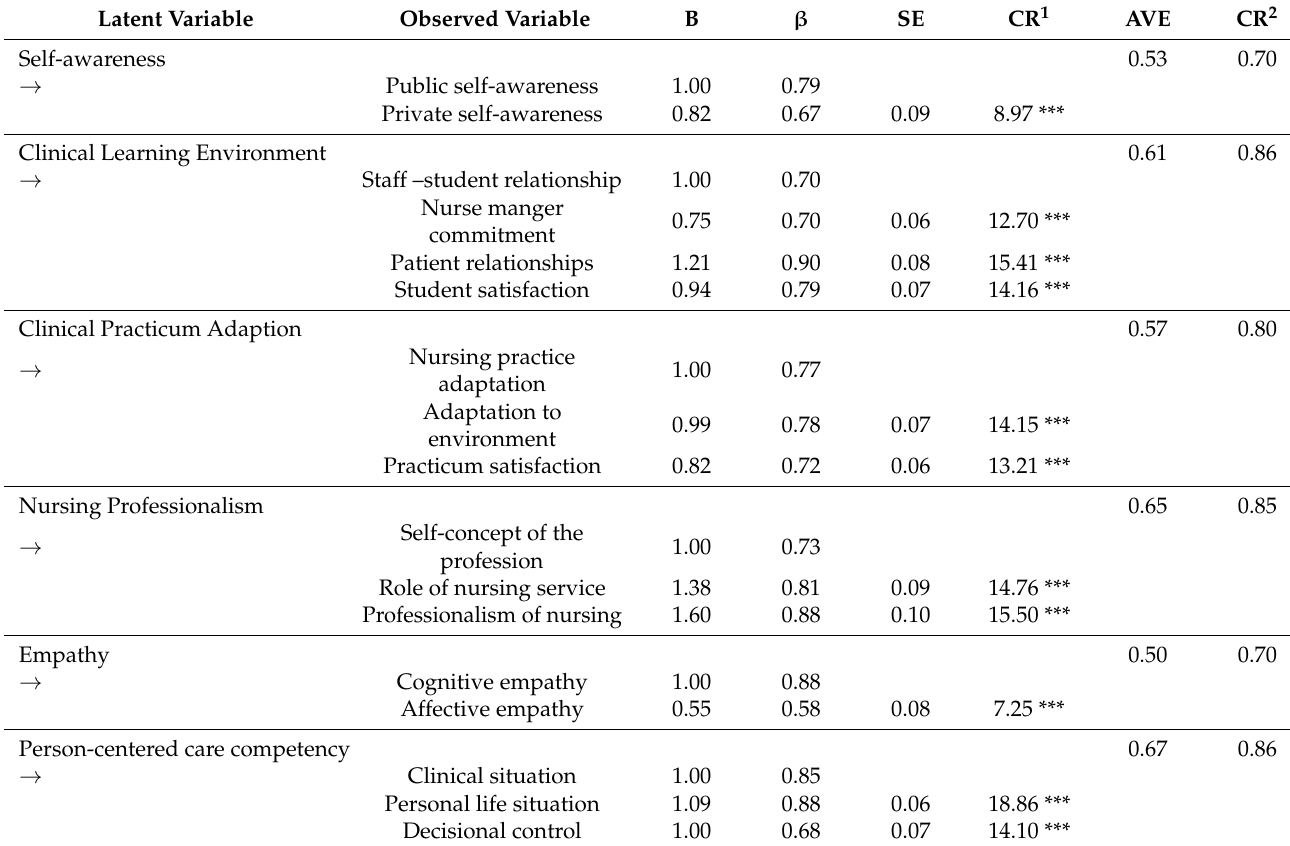
Table 3. Confirmatory factor analysis of the measurement